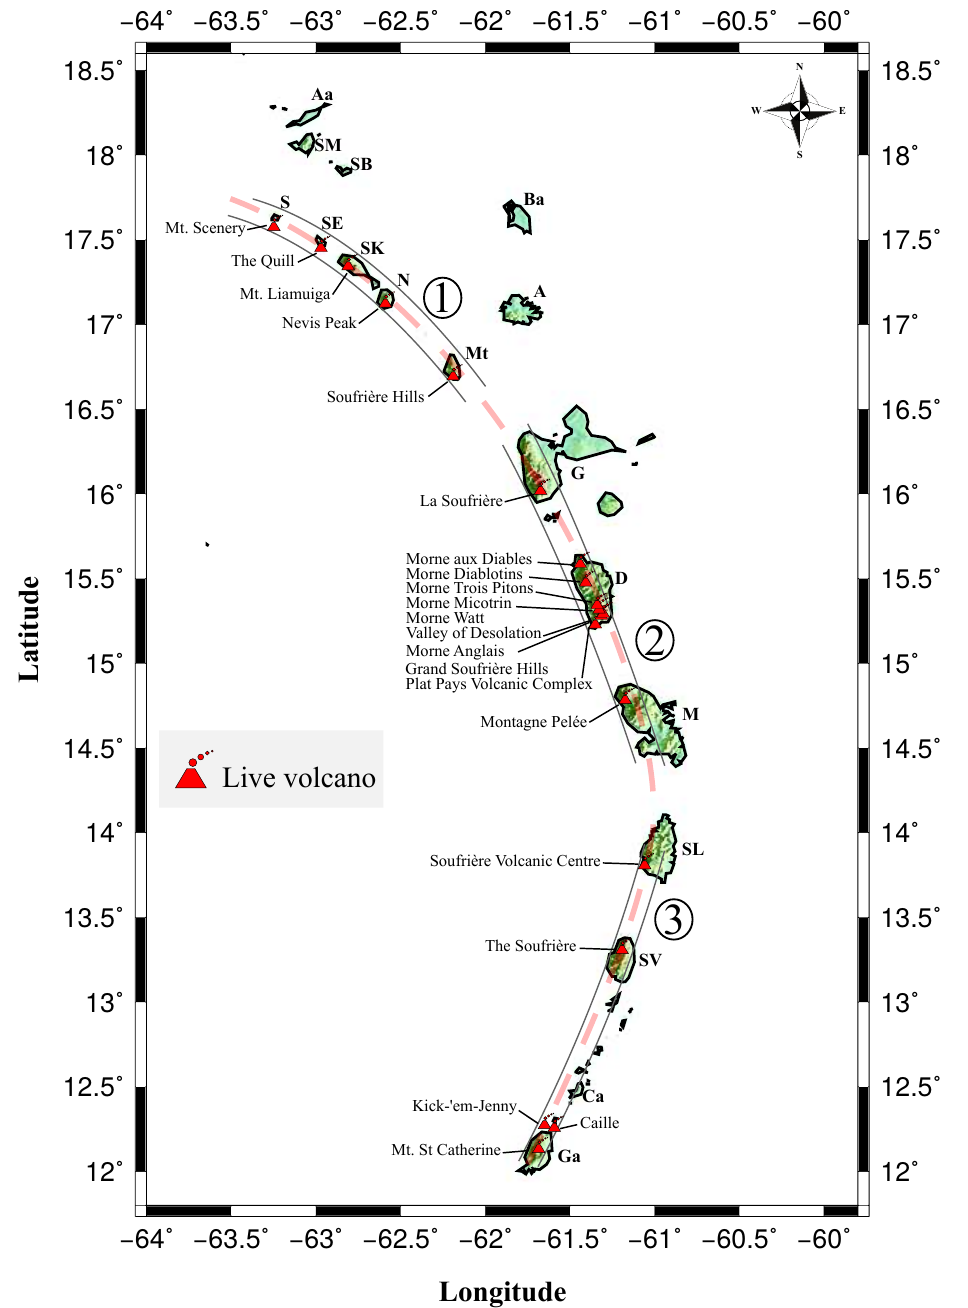
Figure 1. Map showing of the 21 live volcanoes identified along the Lesser Antilles volcanic arc, generated after [7]. Light red dashed-line highlight the active volcanic front. A: Antigua; Aa: Anguilla; Ba: Barbuda; Ca: Carriacou; D: Dominica; G: Guadeloupe archipelago; Ga: Grenada; M: Martinique; Mt: Montserrat; N: Nevis; S: Saba; SB: St Bart; SE: St Eustatius; SK: St Kitts; SL: Saint Lucia; SM: St Marteen; SV: St Vincent. Black parallel lines represent the volcanic segments (see in text); 1: northern segment; 2: middle segment; 3: southern segment. Dark gray parallel lines represent the volcanic segments; 1: northern segment; 2: middle segment; 3: southern segment (see details in